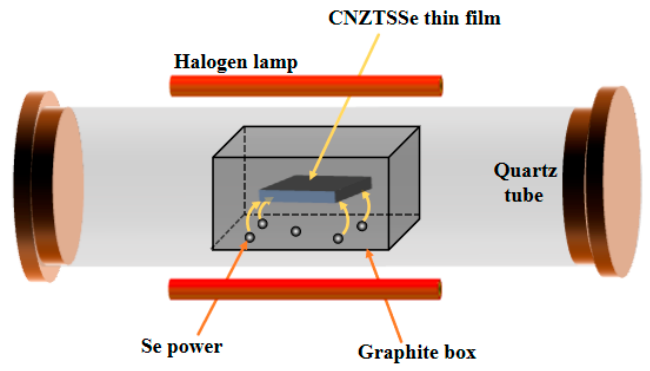
Figure 1. Schematics of graphite box used for selenization annealing.